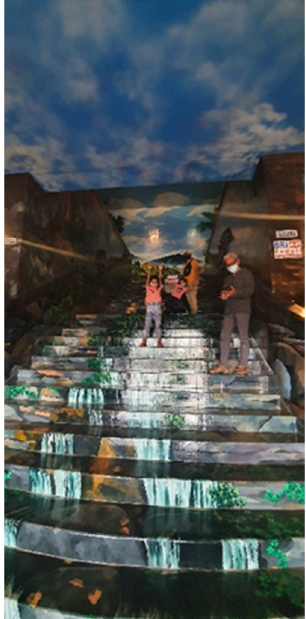
Figure 4: The installation of forest mural in Museum Mandala Bhakti.